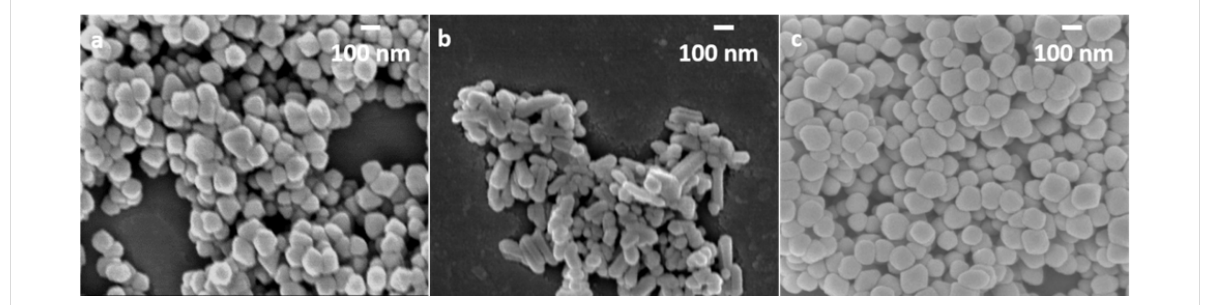
Figure 6: FESEM images of α -Fe 2 O 3 nanoparticles obtained with a) ethylenediamine, b) 1,2-diaminopropane and c) 2,3-diaminobutane, where the Fe 3+ concentration was kept at 0.5 M, magnification: 50,000.